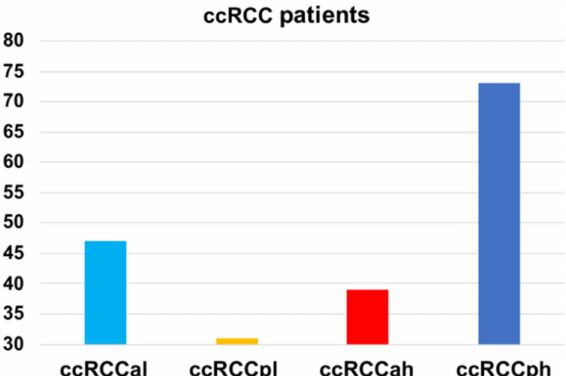
Figure 2. Bar charts showing the distribution of ccRCC patients in the four categories. Note the greater number of patients with collateral vessels and high Fuhrman grades. Shown are patients with an absence of collateral vessels and low Fuhrman grades (ccRCCal); the presence of collateral vessels and low Fuhrman grades (ccRCCpl); an absence of collateral vessels and high Fuhrman grades (ccRCCah); and the presence of collateral vessels and high Fuhrman grades (ccRCCph). Similar results were found with male patients (MccRCCal n = 33; MccRCCpl n = 18; MccRCCah n = 27 and MccRCCph n = 49) with statistically significant different distribution ( p < 0.005) (Figure 3). Conversely, no statistically significant differences ( p = 0.31) were detected in the subanalysis performed with the female patient ccRCC subgroups (FccRCCal